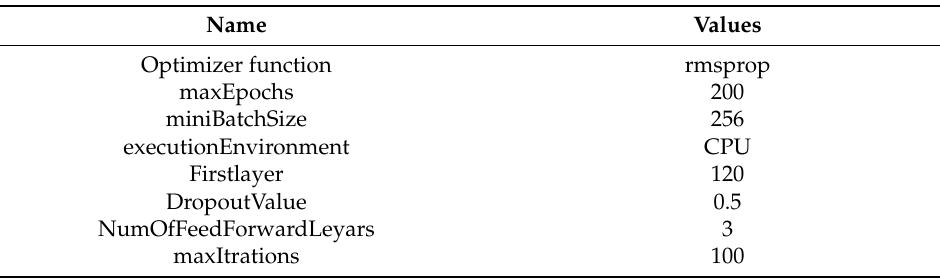
Figure 5. Structure of the CNN-LSTM model. Table 1. Deep learning parameters.